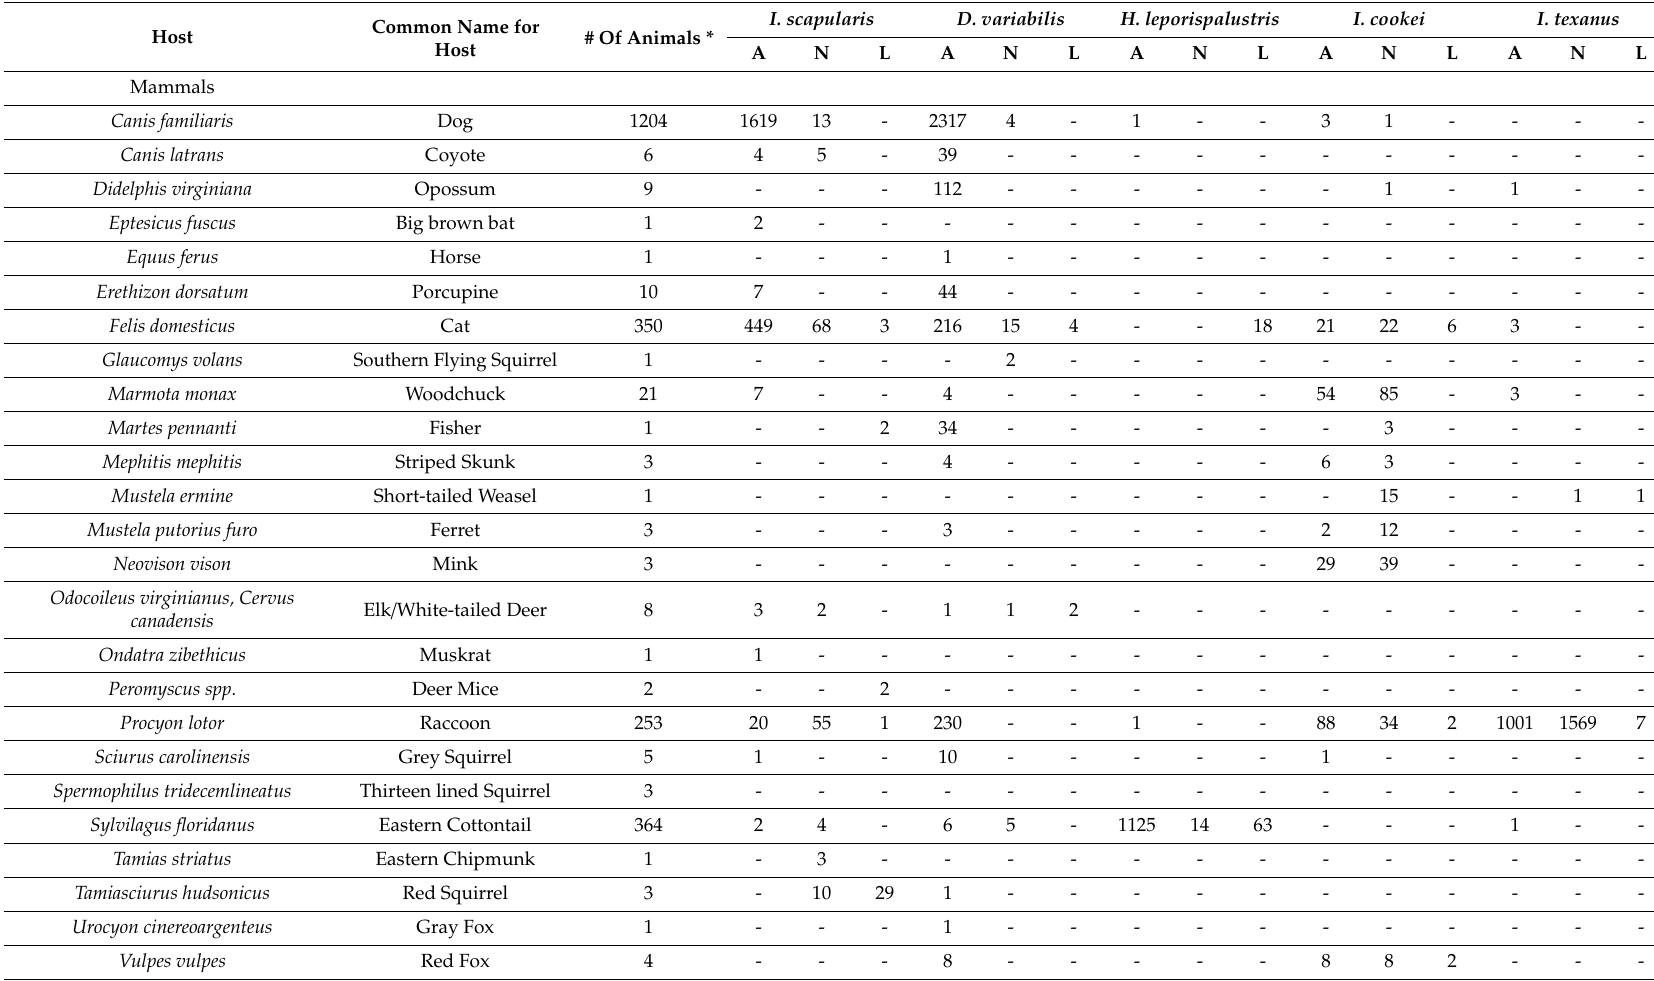
Table 1. Summary of the animals examined for the Surveillance of Wisconsin Animals for Ticks (SWAT) program (2011–2017) and the most commonly collected ixodid